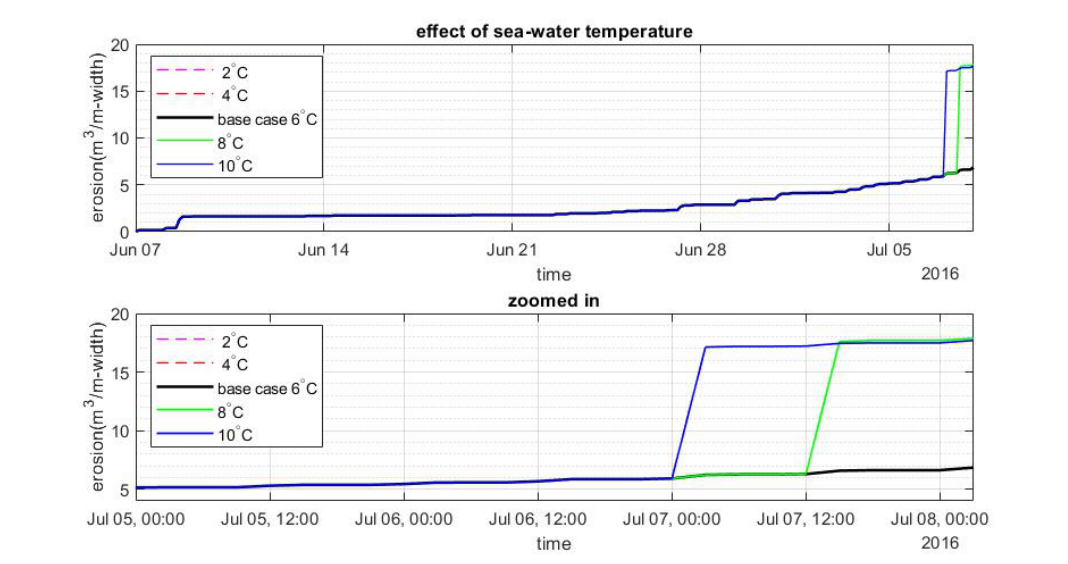
Figure A11. The effect of water temperature inputs on erosion.